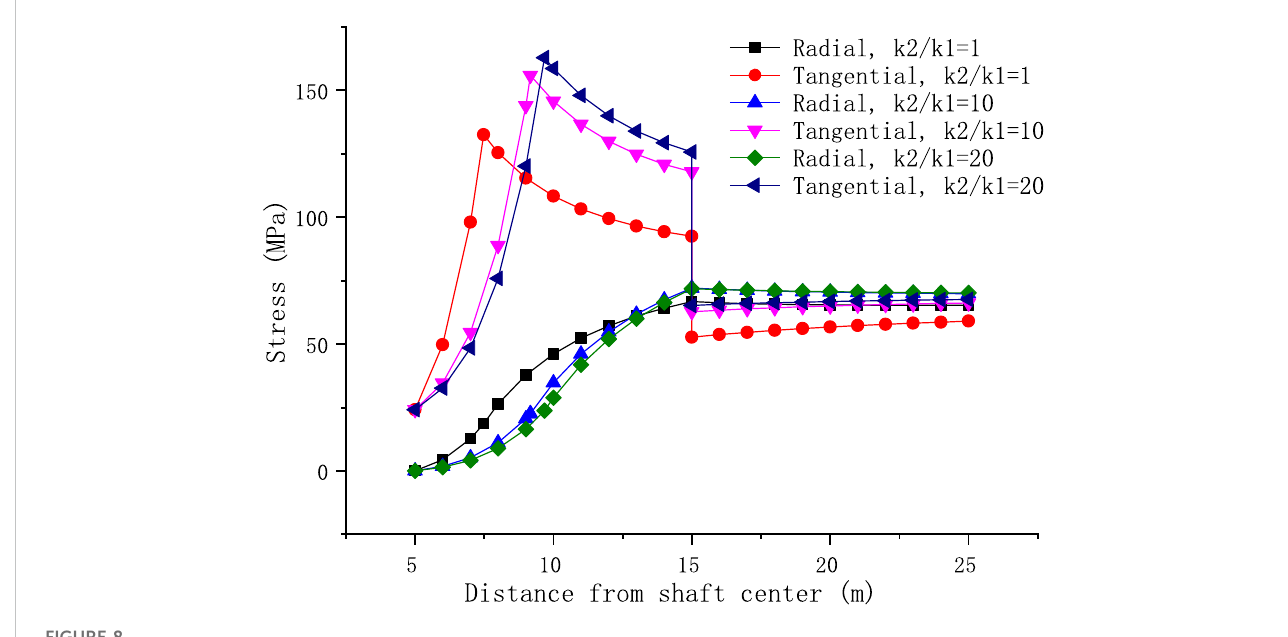
FIGURE 8 Stress distribution under different permeability coef fi cient ratios.